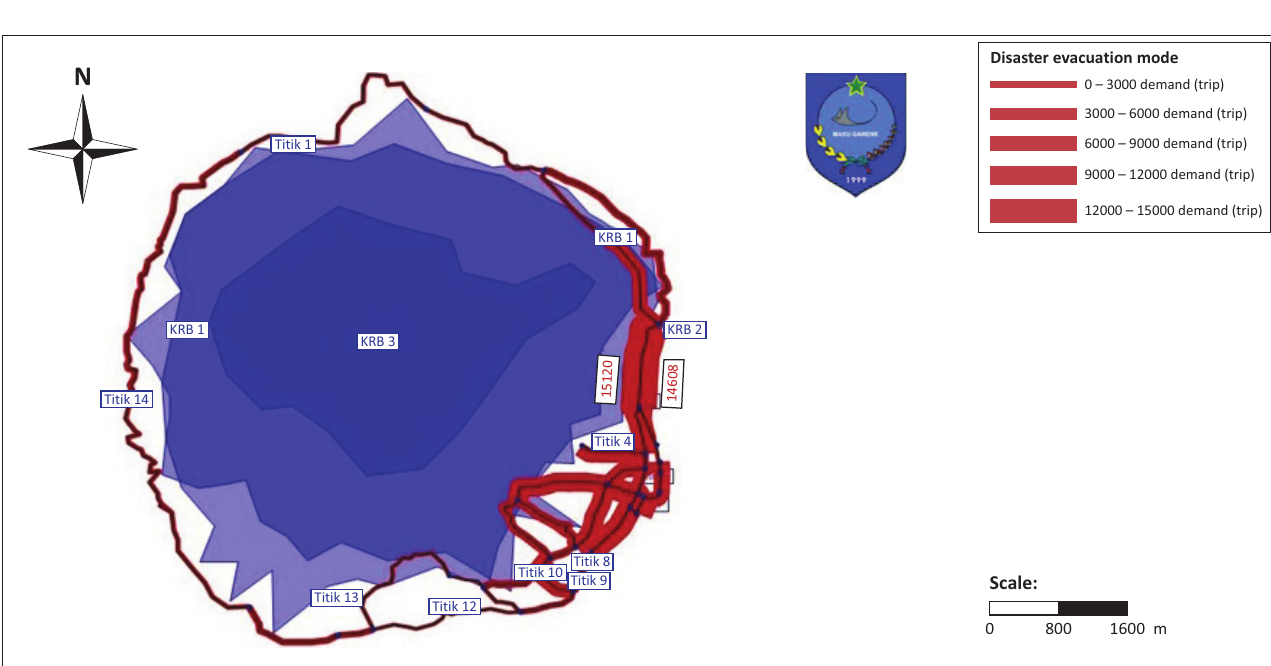
FIGURE 6 : The map of disaster evacuation mode.